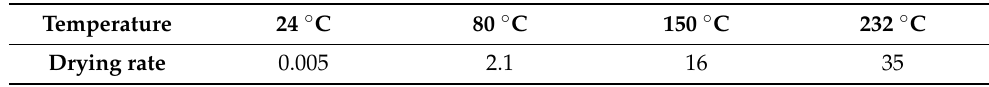
Table 2. Average drying rates (mg/s) at different